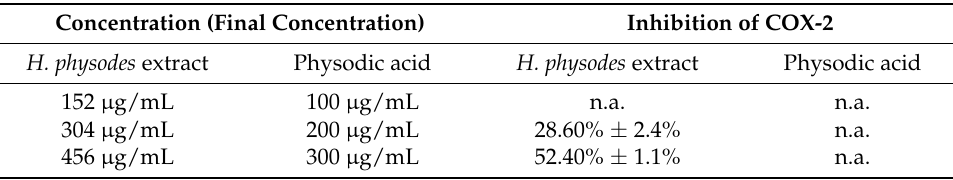
Table 2. Inhibition of cyclooxygenase-2 (COX-2) by Hypogymnia physodes extract ( H. physodes extract) and physodic acid.